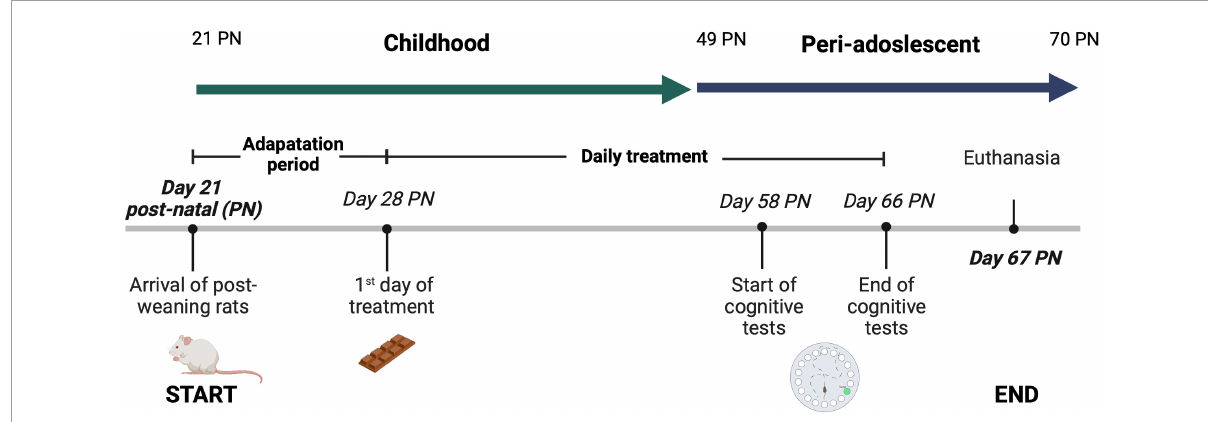
FIGURE1 Experimental protocol. Treatments were administered for 38 days, starting after the seven-day adaptation period until the previous day of sacrifice, considering the seven-day cognition test. Each rat group was given its respective treatment from 2 p.m. to 5 p.m. After 31 days of treatment (day 58 post-natal (PN), the rats were subjected to the Barnes Maze (BM) test to evaluate spatial learning and short and long-term memory. The rats were kept under standard nursery conditions at a controlled temperature of 22 ◦ C ± 1 ◦ C, with light-dark cycles of 12 h, allowing ad libitum access to water and commercial rodent food throughout the experimental period. Body weights were recorded weekly. A 38-day administration period was selected since is the required period to observe an effect on rat’s behavior when probiotics are supplemented (18). Also, the supplementation of the treatment started at the post-weaning period, 21 days post-natal (PN), because is the age at which the hippocampus and pre-frontal cortex begin to contribute to learning processes (19). Rats have an accelerated childhood compared to humans, and this investigation is targeted to assess the effect of childhood supplementation of nutraceuticals on spatial learning and memory in male Wistar rats. Therefore, in this protocol the animal model was supplemented with the bioactive ingredients during childhood and no longer than adulthood ( > 70 post-natal) (20). This experimental protocol was reviewed and approved by the Research Ethics Committee of University of Guadalajara (CIN/034/2022). Figure created with